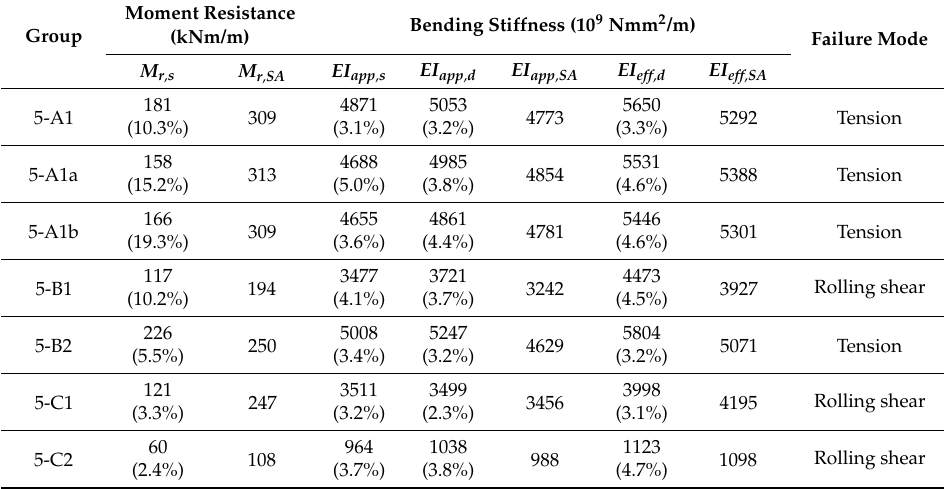
Table 4. Bending properties of 5-layer